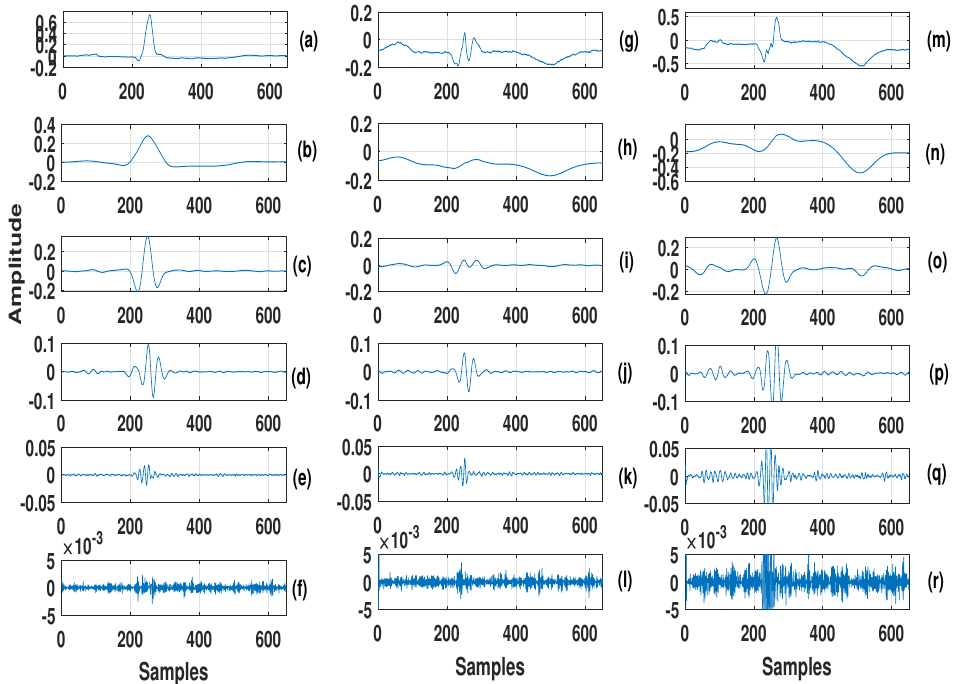
Figure 3. ( a ) V x lead VCG signal for IPLMI class. ( b – f ) mode 1 to 5 of V x lead VCG signal for IPLMI class. ( g ) V y lead VCG signal for IPLMI class. ( h – l ) mode 1 to 5 of V y lead VCG signal for IPLMI class. ( m ) V z lead VCG signal for IPLMI class. ( n – r ) mode 1 to 5 of V z lead VCG signal for IPLMI